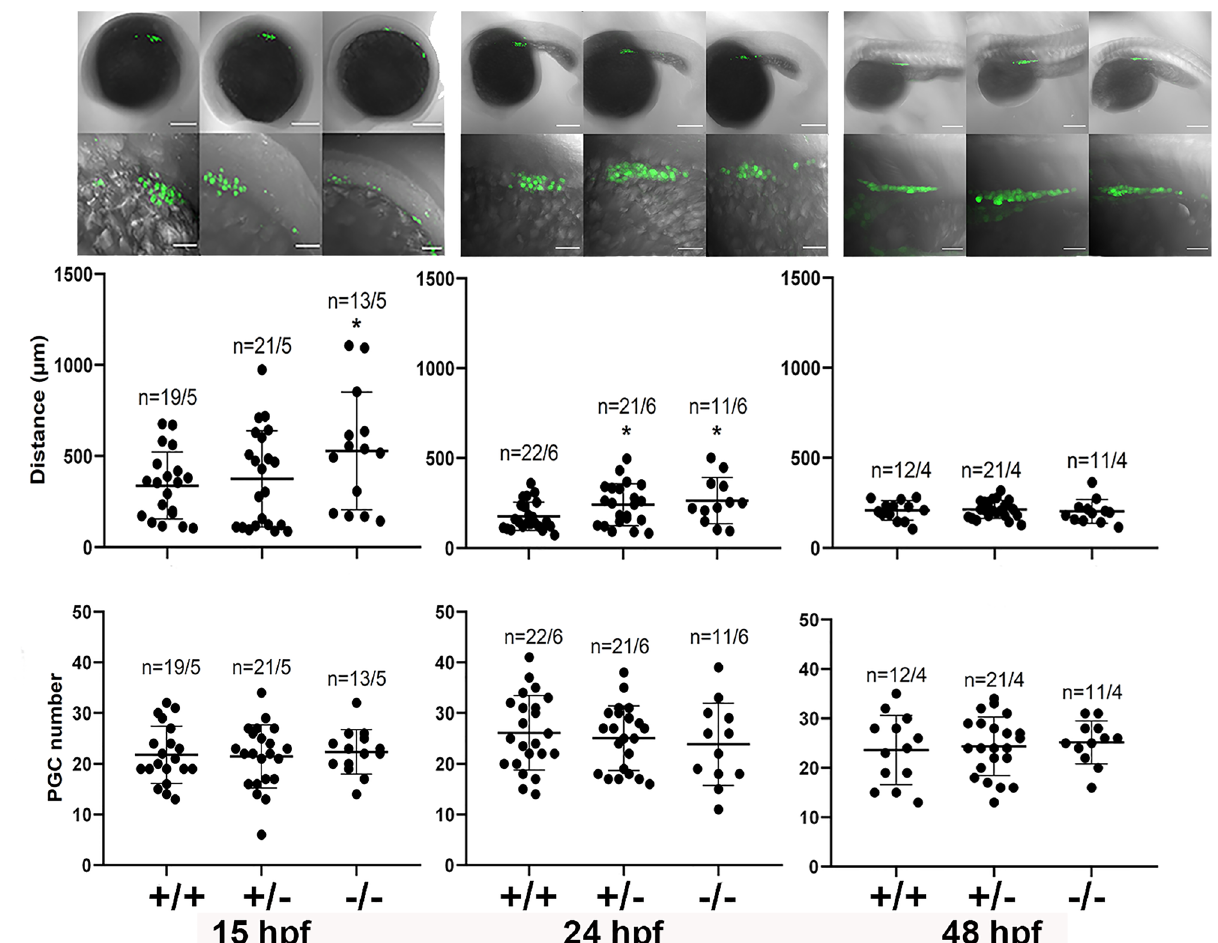
Figure 6. Delayed primordial germ cell (PGC) migration in Adamts9 knockout zebrafish during early development. PGC is labeled with GFP by crossing Adamts9 KO with Tg(vasa:GFP). Distance between two most distant PGCs were determined as an indicator of PGC migration (See Fig. 7 for detail). Showing distance, number of PGC, or representative images of zebrafish embryos at 15, 24 or 48 h post fertilization (hpf) in wildtype (+/+), heterozygous (+/–), and homozygous (–/–) Adamts9 KO. Embryos from at least 4 sets of parents were analyzed. The numbers on the left side of the forward slash is the number of embryos analyzed, and the numbers on the right side of the forward slash indicate sets of parents used for producing these embryos. Top panels are representative confocal images showing entire or part of embryos with GFP labeled PGC at a low magnification (scale bar: 200 μm). Bottom row are magnified confocal images of the embryos from the top (scale bar: 50